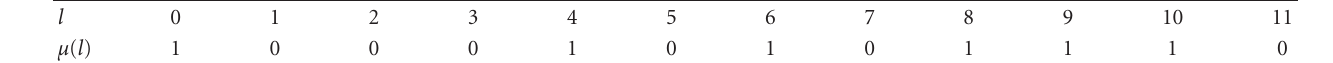
Table 1: The multiplicity μ ( l ) of the OSAF with l ≤ 11.